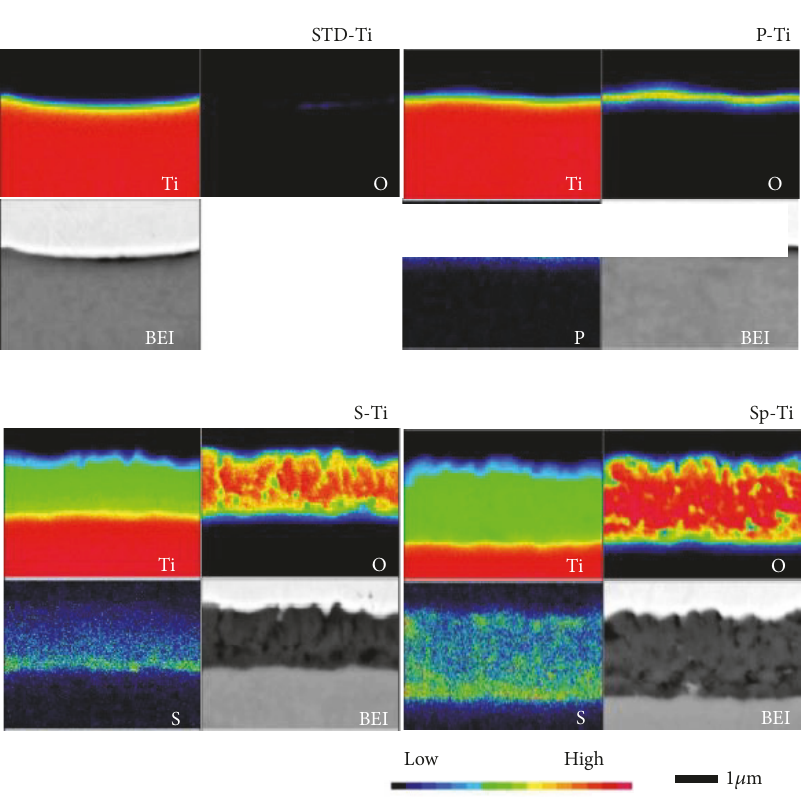
Figure 6: EPMA analysis of cross sections of the anodized Ti plates.